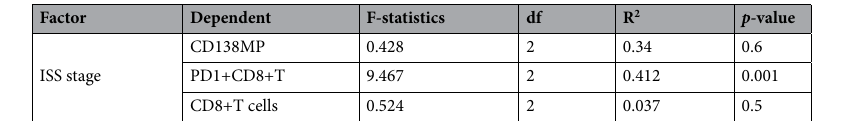
Table 7. Multivariate analysis of normally distributed variables on ISS stage. df: degrees of freedom; ISS: international staging system; PD1: programmed death-1; one way Manova for significance, p < 0.05.